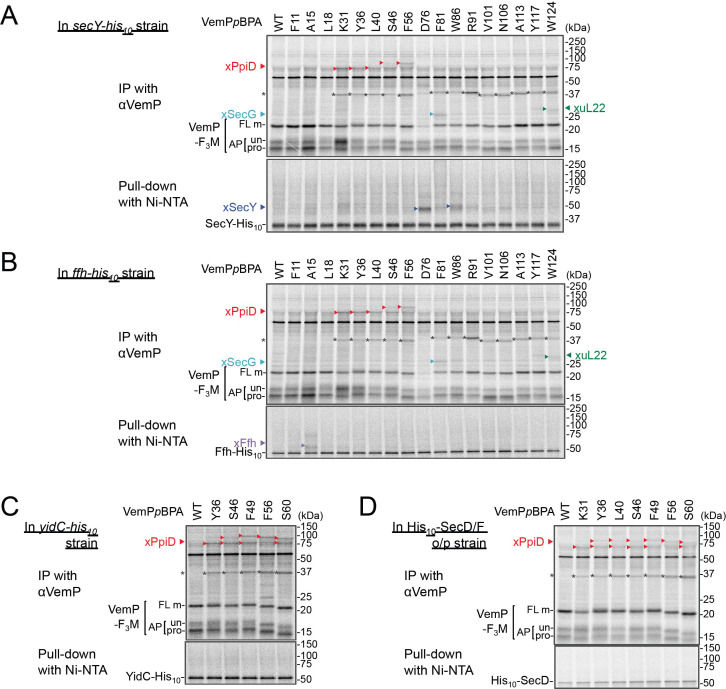
Identification of VemP crosslinked products using His-tagged derivatives of candidate proteins.(A–D) VemP PiXie analysis in cells expressing His10-tagged proteins. E. coli strains, RM2834 (expressing SecY-His10 from the chromosome, A), RM2831 (Ffh-His10, B), and RM2935 (YidC-His10,C) were constructed (see Materials and methods) and used. The cells of the indicated strains were grown, induced to express a VemP-F3M derivative with pBPA at the indicated position and analyzed by the PiXie methods as described in Figure 1. Labeled proteins were subjected to IP with an anti-VemP antibody (upper gel) or pull-down with Ni-NTA agarose (lower gel). Immuno-isolated proteins were analyzed as in Figure 1. (D) secD1 mutant cells over-expressing His10-SecD/F were grown and induced to express a VemP-F3M derivative with pBPA at the indicated position and analyzed by PiXie as in Figure 1. Labeled proteins were subjected to IP with the anti-VemP antibody (upper gel) or pull-down with Ni-NTA agarose (lower gel). Immuno-isolated proteins were analyzed as in Figure 1. The result shown is a representative of two technical replicates. Asterisks in A–D represent crosslinked dimer forms of VemP-F3M.